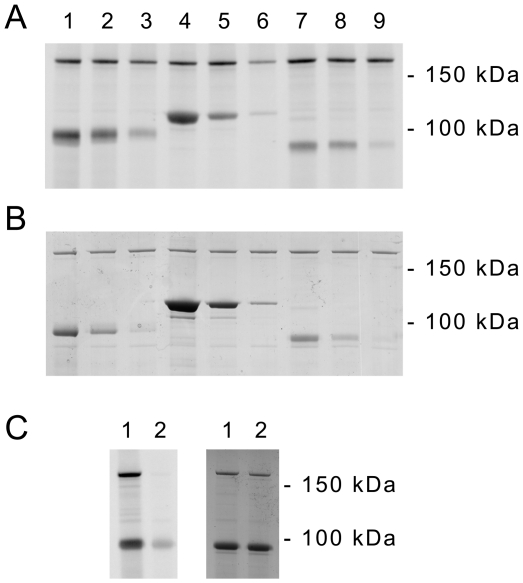
Retinoic acid receptor alpha is efficiently phosphorylated by recombinant LRRK2.(A) Autoradiogram demonstrating phosphorylation of recombinant tubulin-beta 2C (lane 1–3), heat-treated meosin (lane 4–6), and retinoic acid receptor alpha (lane 7–9) by recombinant LRRK2(G2019S) (amino acids 970-2527). Three-fold dilutions of each recombinant protein were incubated with kinase and [γ-33P]ATP for 45 min. (B) Coomassie Blue protein post-staining of the gel. (C) (Left panel) Kinase-dead LRRK2(D1994A) does not autophosphorylate or phosphorylate retinoic acid receptor alpha (lane 2) compared to active LRRK2(G2019S) (lane 1). (Right panel) Similar protein amounts are detected by Coomassie Blue protein staining.